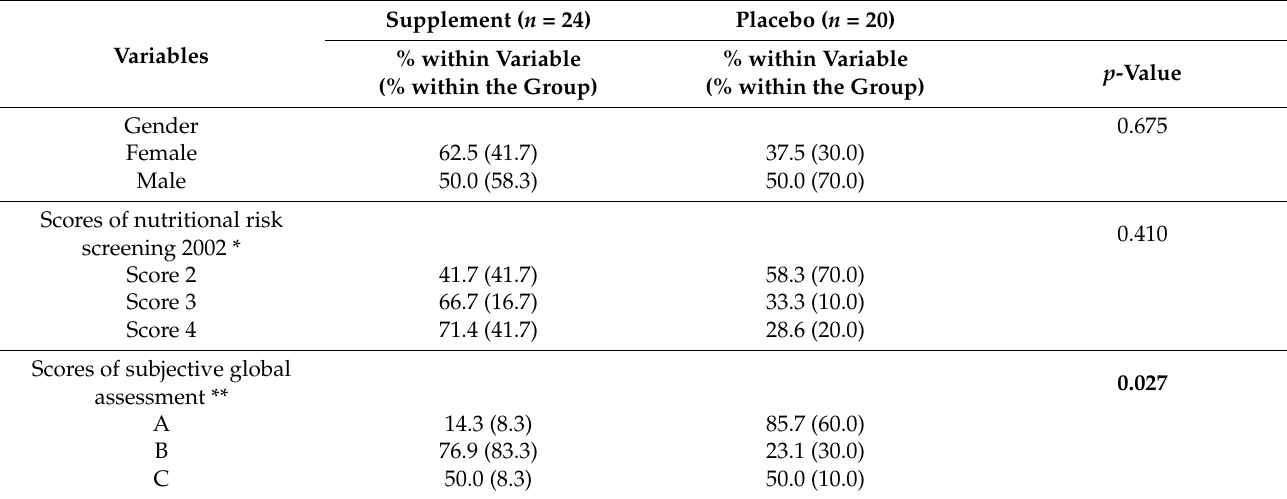
Table 1. Baseline nutritional risk screening parameters and subjective global assessment parameters of study groups.